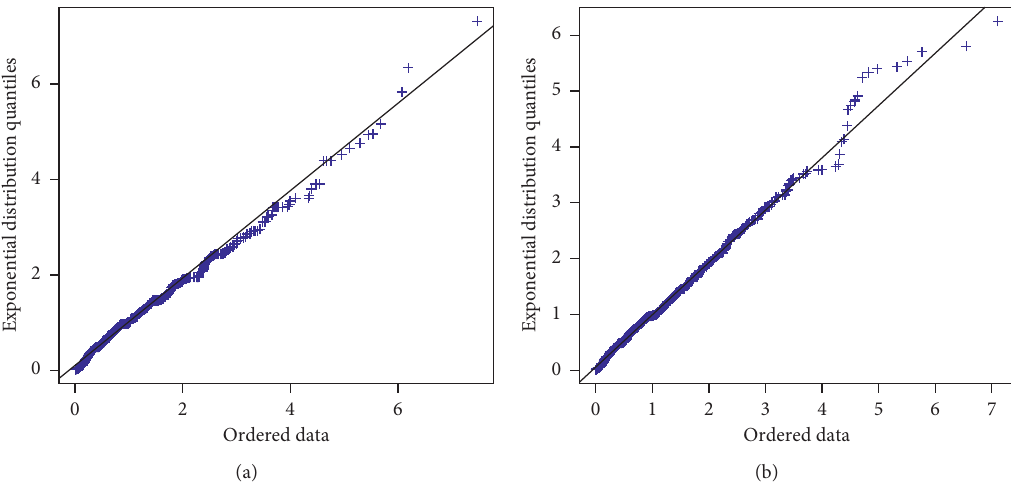
Ordered data Figure 4: QQ-plots of Hawkes process fitting for the (a) SH composite index and (b) SZ component